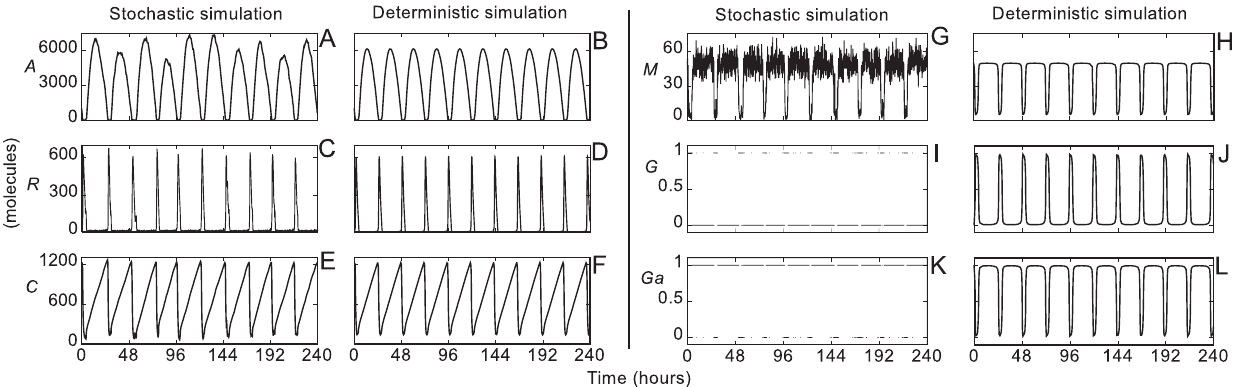
Figure 3. Stochastic and deterministic simulations of the model. A, C, E, G, I, K. Stochastic time evolution of the protein ( A ), repressor ( R ), protein-repressor complex ( C ), mRNA ( M ), gene ( G ) and activated gene ( G a ), respectively. B, D, F, H, J, L. Deterministic time evolution of A , R , C , M , G , and G a , respectively. In both simulations, the time evolution of A ( A and B ), R ( C and D ) and C ( E and F ) are very similar except for the presence of fluctuations in the stochastic case. This phenomenon is more pronounced in the time evolution of M ( G and H ). The oscillations in C show sawtooth waveforms. There is a single gene in the model; hence G z G a ~ 1 molecule. In the time evolution of G ( I and J ) and G a ( K and L ), the stochastic simulation shows discrete transitions between 0 and 1 molecules. By contrast, the deterministic simulation shows unrealistic continuous transitions. The time evolution of G a shows that the gene is activated most of the time ( K and L ).